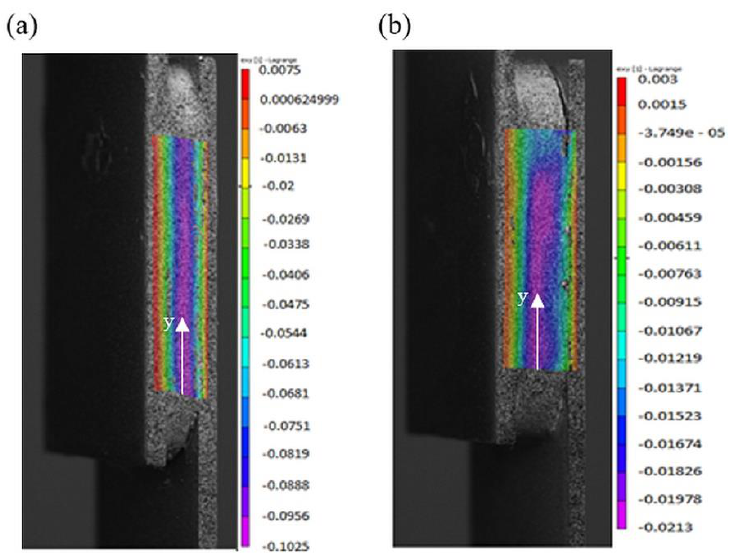
Figure 10. ( a ) Shear strain field for a 2 mm thickness PDMS plate; ( b ) Shear strain field for a 4 mm thickness PDMS plate.